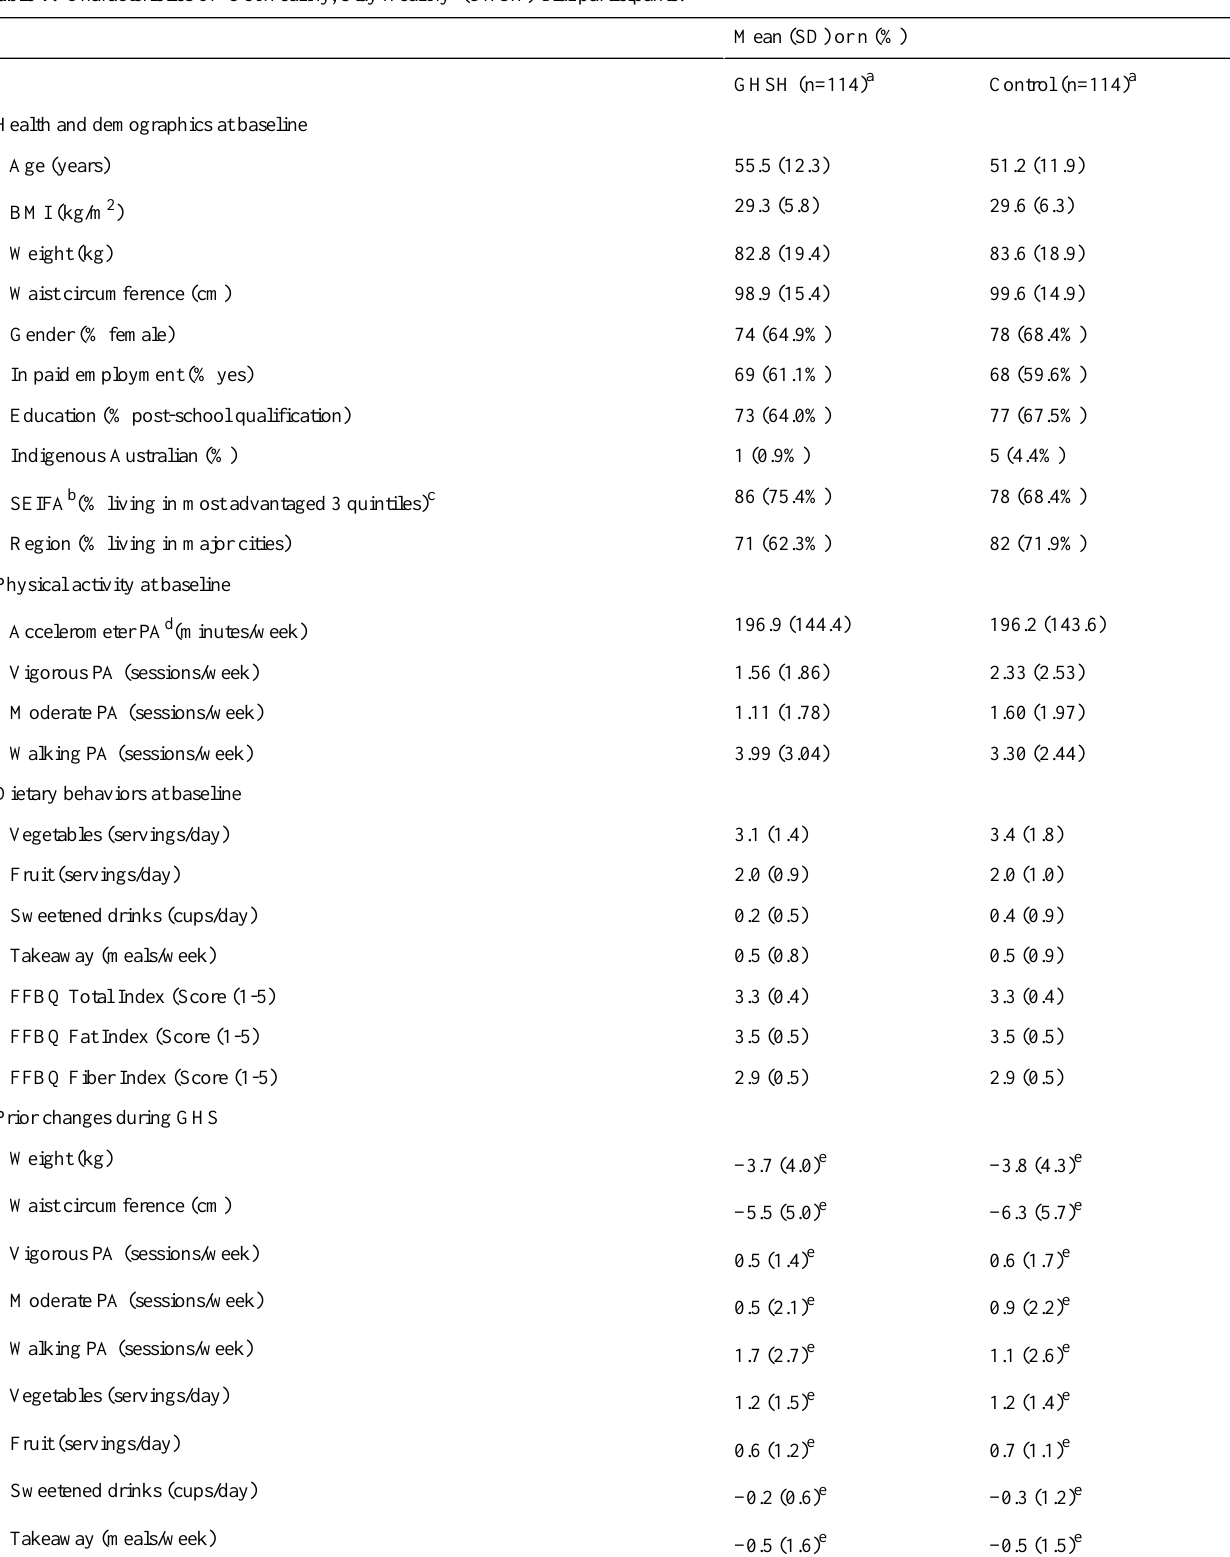
Table 1. Characteristics of ‘Get Healthy, Stay Healthy’(GHSH) trial